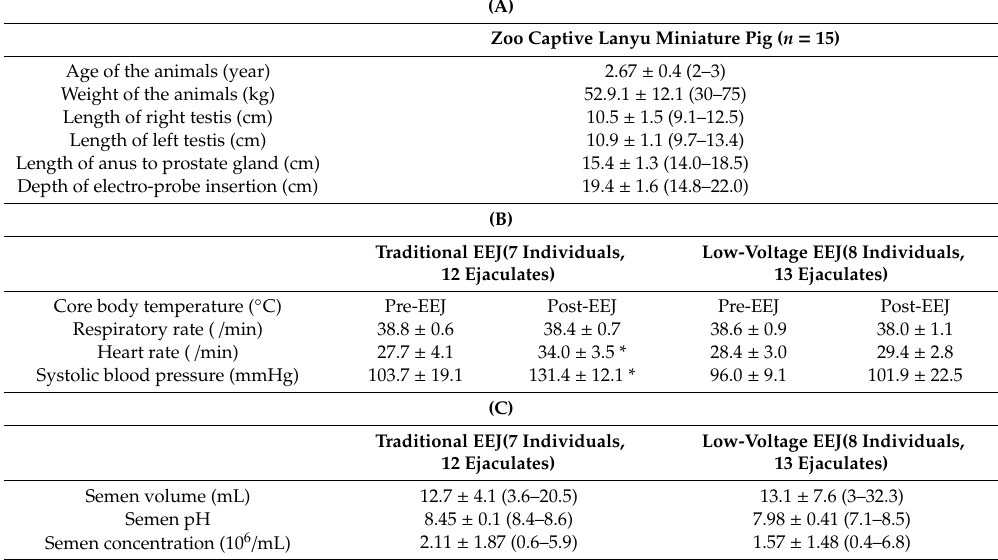
Table 1. Physiological parameters and general semen characteristics. ( A ) General physiological parameters of lanyu miniature pigs used in the study. Age of the animals, body weight, the size of the testes and the length of anus to prostate gland was measured and recorded. ( B ) Core body temperature, respiratory rate, heart rate, and systolic blood pressure were monitored throughout the experiment, pre- and post-EEJ values were compared. ( C ) Semen volume, pH, and sperm concentration were recorded for both traditional and low-voltage EEJ. Asterisks indicated statistical di ff erence between pre- and post EEJ